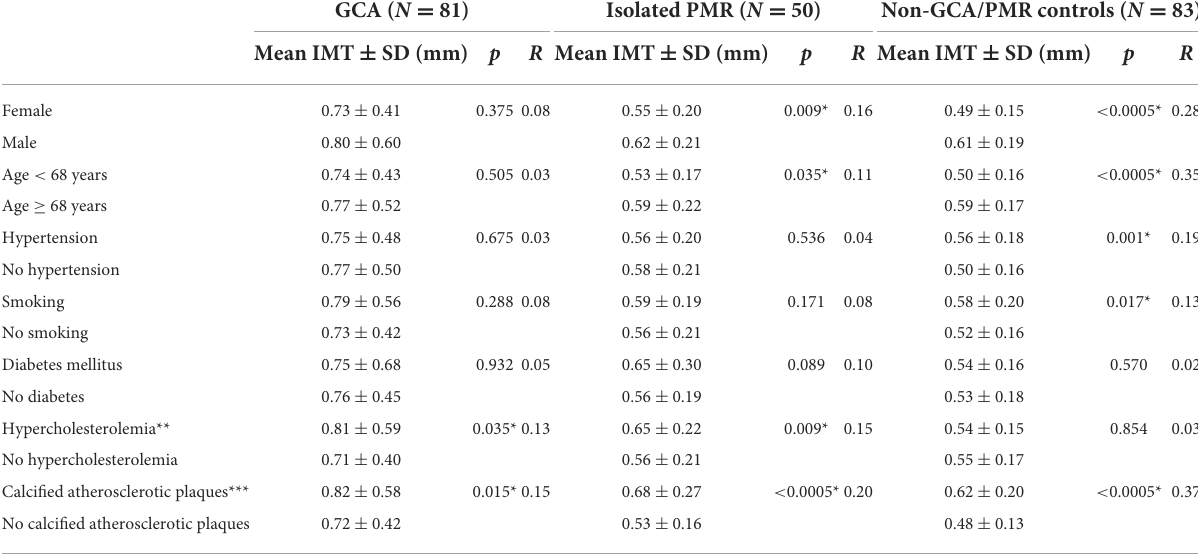
TABLE 3 Factors potentially influencing intima-media thickness in GCA, isolated PMR, and controls.